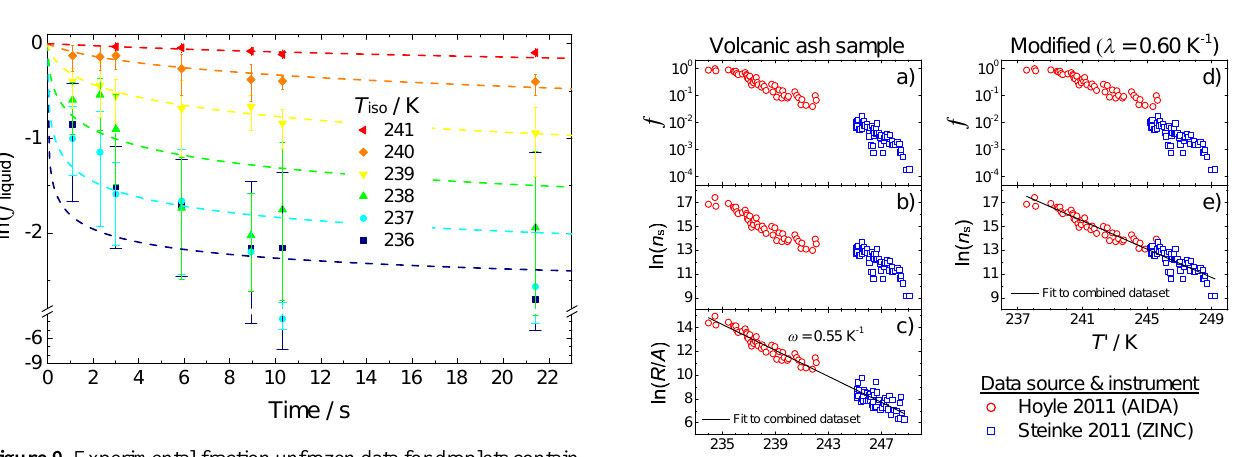
Figure 9. Experimental fraction unfrozen data for droplets contain- ing Fluka kaolinite (symbols) in Fig. 8a (Welti et al., 2012) plotted as a function of time and temperature. We also plot the expected decay of liquid droplets with time determined using Eq. (26) with the function of n s (T 0 ) in Fig. 8e and λ = 2.19K − 1 . The expected decay at each temperature is shown as a dashed line.